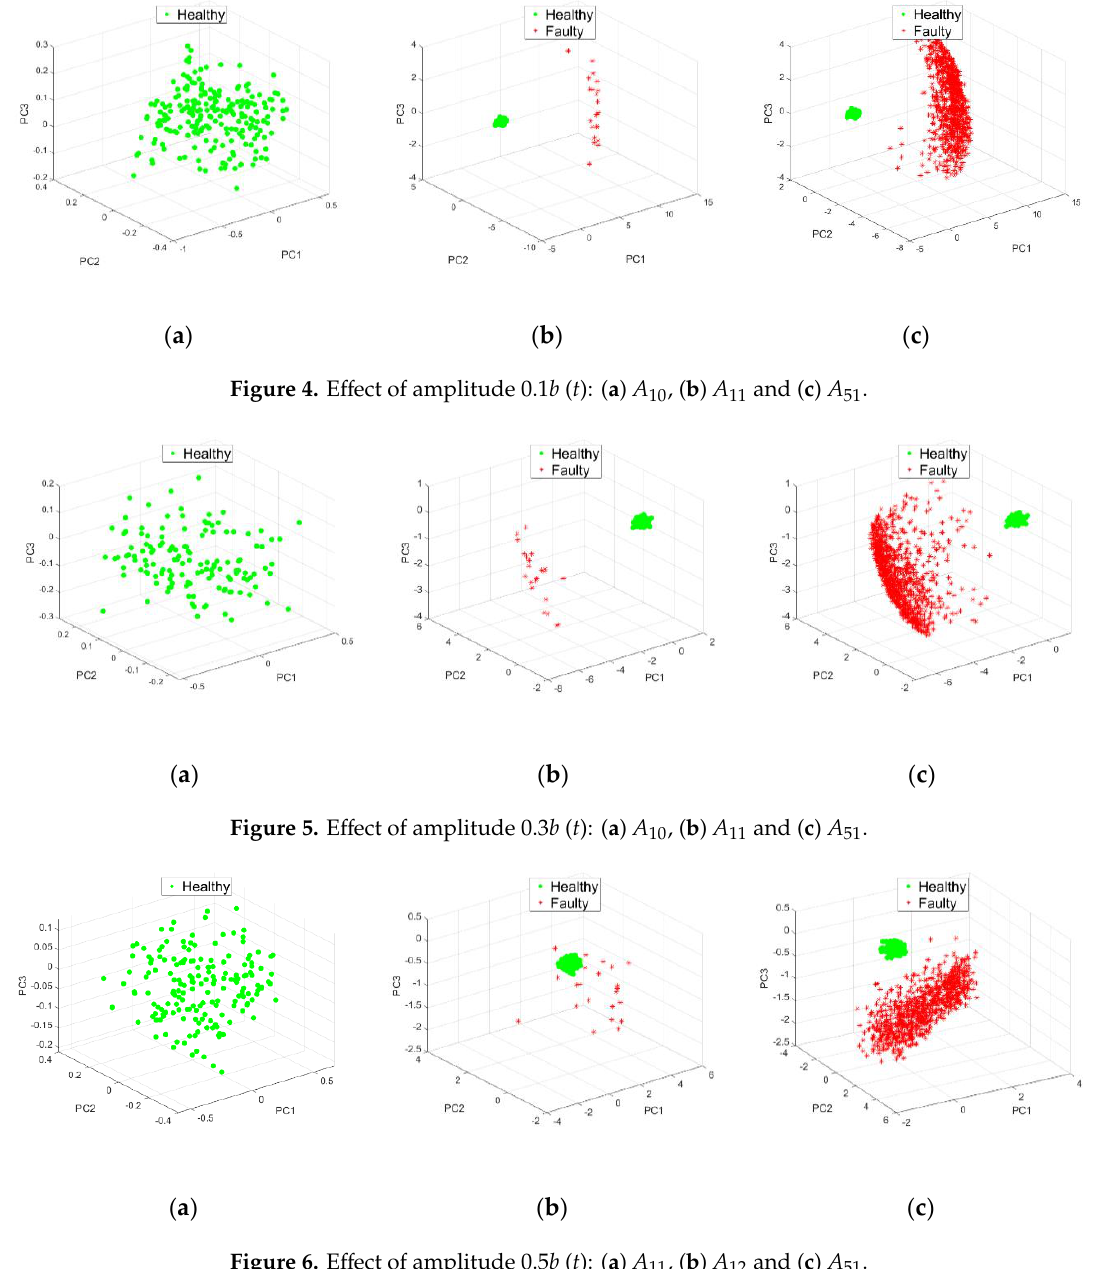
Figure 6. E ff ect of amplitude 0.5 b ( t ): ( a ) A 11 , ( b ) A 12 and ( c ) A 51 Figure 6. Effect of amplitude 0.5 b (t) : ( a ) 𝐴 11 , ( b ) 𝐴 12 and ( c ) 𝐴 51 . Figure 6. Effect of amplitude 0.5 b (t) : ( a ) 𝐴 11 , ( b ) 𝐴 12 and ( c ) 𝐴 51 . Figure 6. Effect of amplitude 0.5 b (t) : ( a ) 𝐴 11 , ( b ) 𝐴 12 and ( c ) 𝐴 51 .